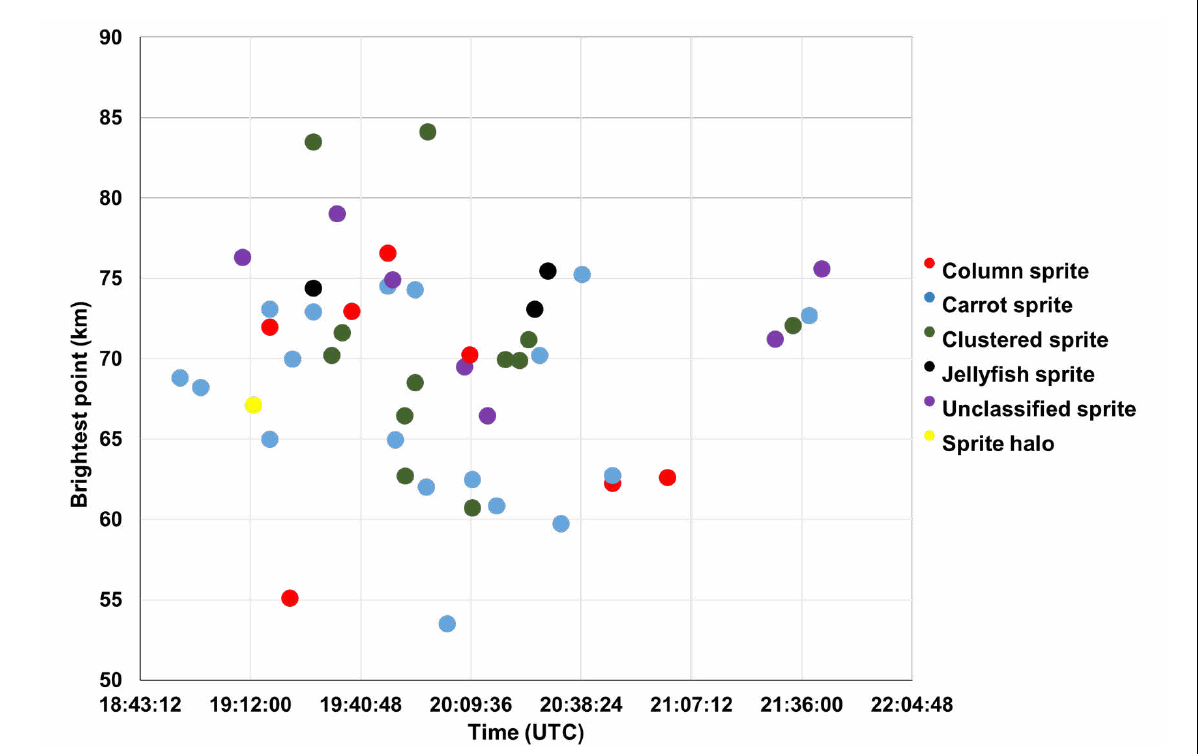
Figure 4: The altitude of maximum brightness of the 48 sprites with respect to their time of